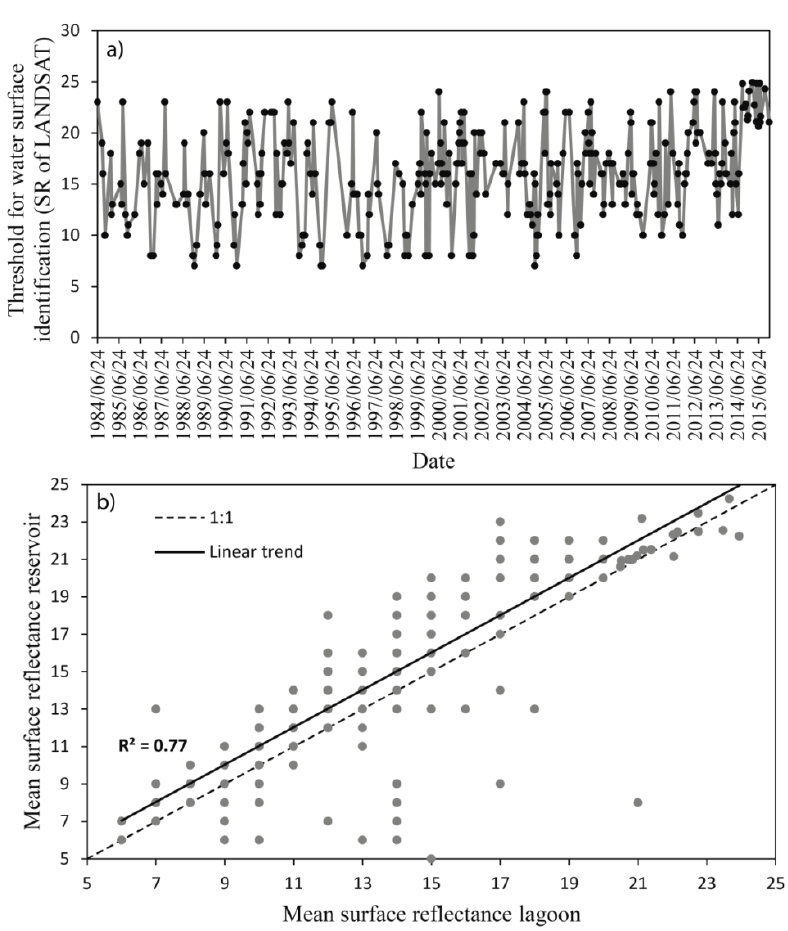
Figure 5. Surface reflectance of the calibration areas: ( a ) temporal dynamic of the surface reflectance threshold used to identify the surface water; ( b ) comparison of the mean surface reflectance of the two areas used for calibration.